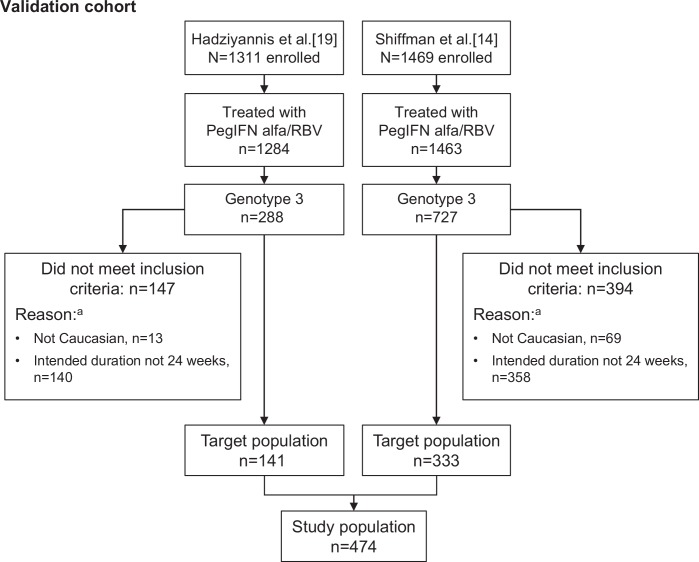
Patient selection for the validation cohort.